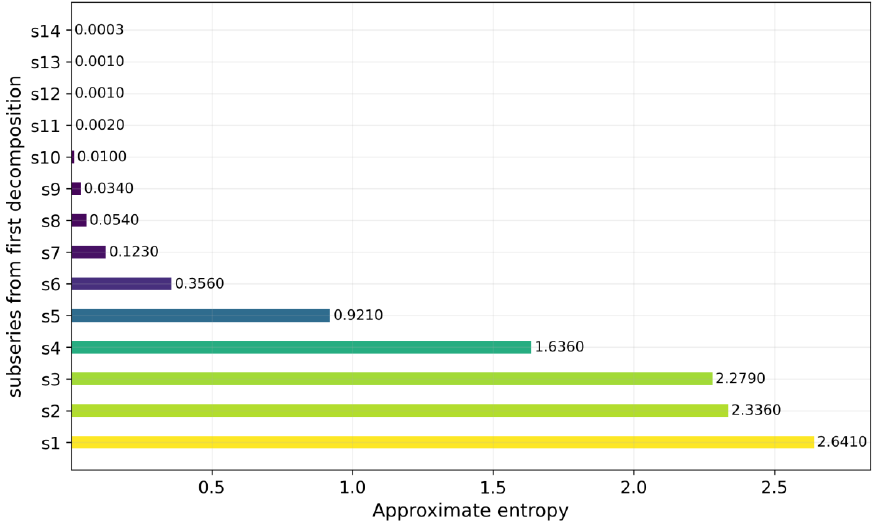
Figure 15. CEEMDAN and AE calculation.